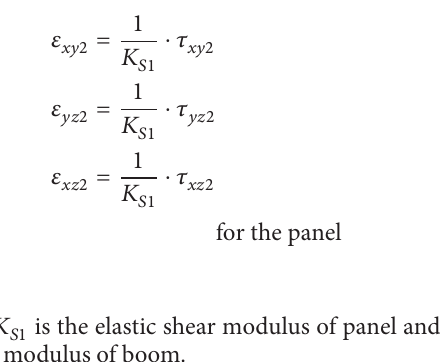
damageBoomPanel damageElastic block without Boom-panel structure unit with Figure 1: The microstructure mechanical